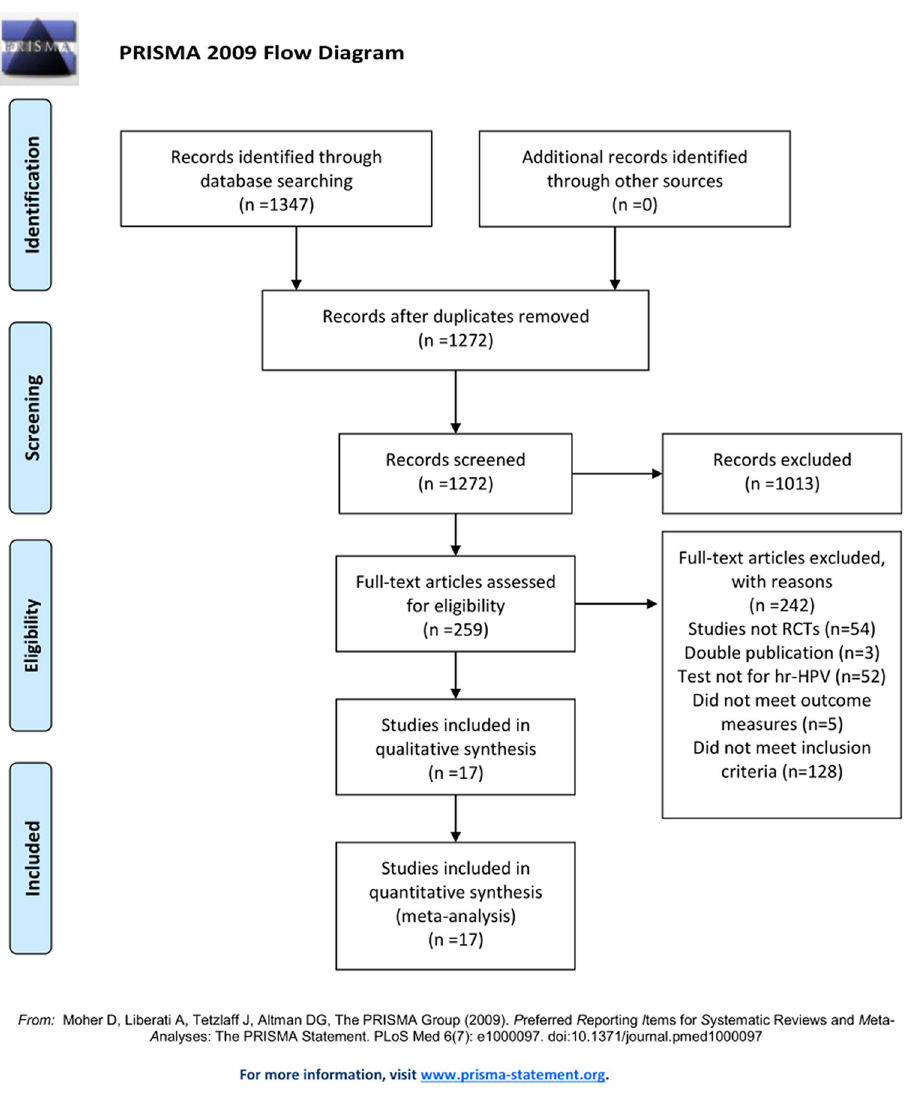
Fig 1. Flow diagram for the process of identifying eligible randomized controlled